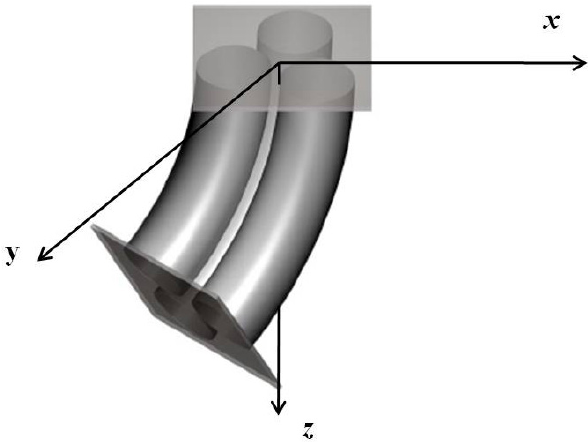
Figure 3. Bending of a section due to di ff erence in actuator pres- sure levels (Jones and Walker,